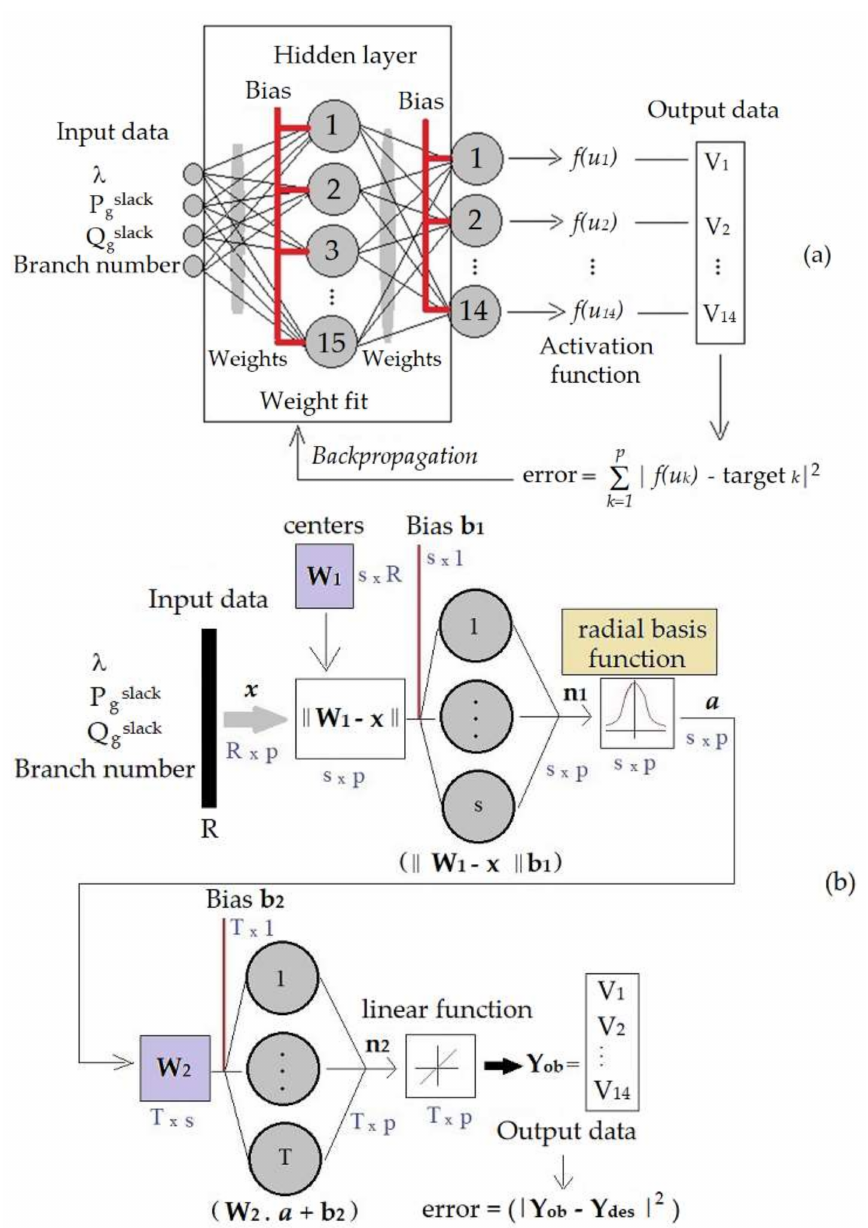
Figure 2. RNA used in this study; ( a ) MLP, ( b )